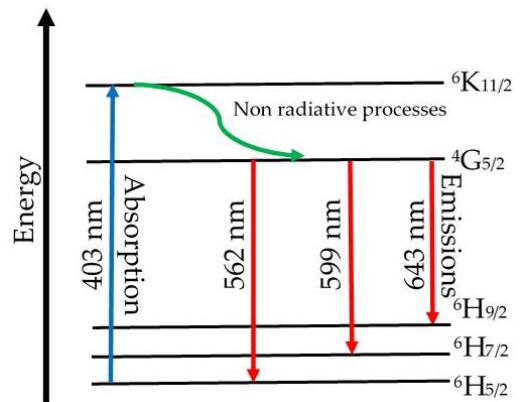
Figure 6. Energy level diagram with absorption and emissions for Sm 3 + ions in (CuNPs) x · (P 2 O 5 ) 35 · (Sb 2 O 3 ) (64 − x) · (Sm 2 O 3 ) 1 glasses.